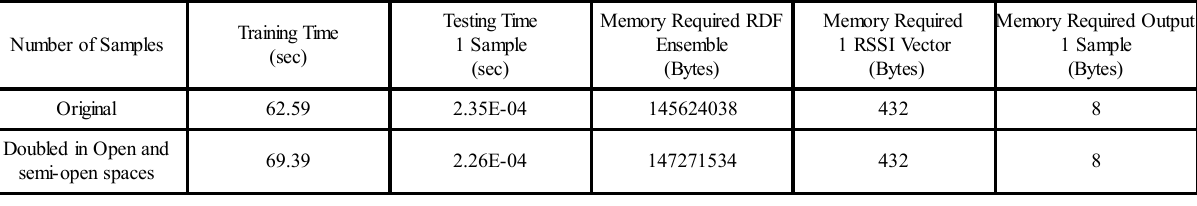
TABLE 8. COMPLEXITY ANALYSIS WITH INCREASING RSSI